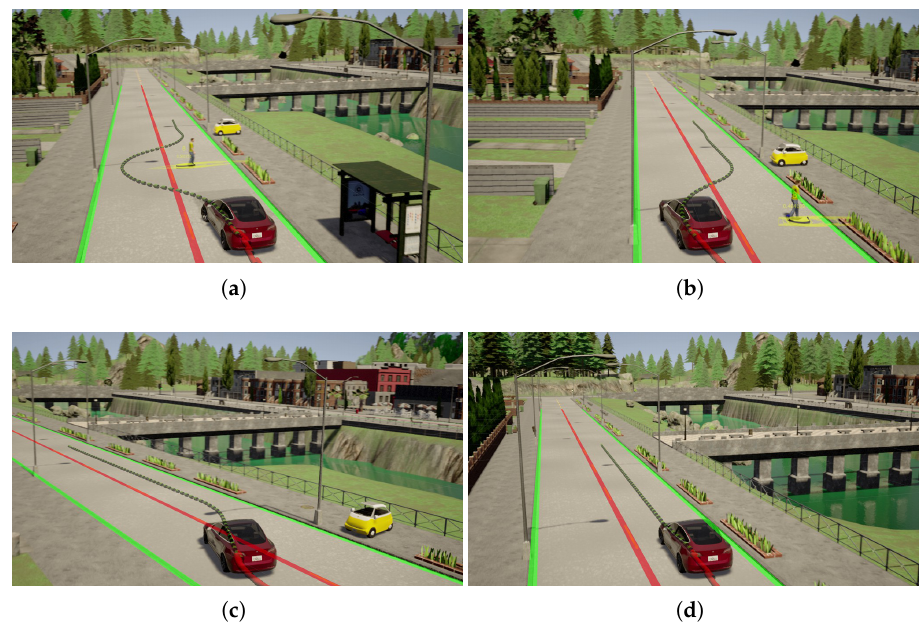
Figure 19. The CAV safely navigated around the crossing pedestrian autonomously based on the CPMs from the IRSU in the CARLA simulator. ( a – d ) sequentially show the complete pedestrian avoidance maneuver of the